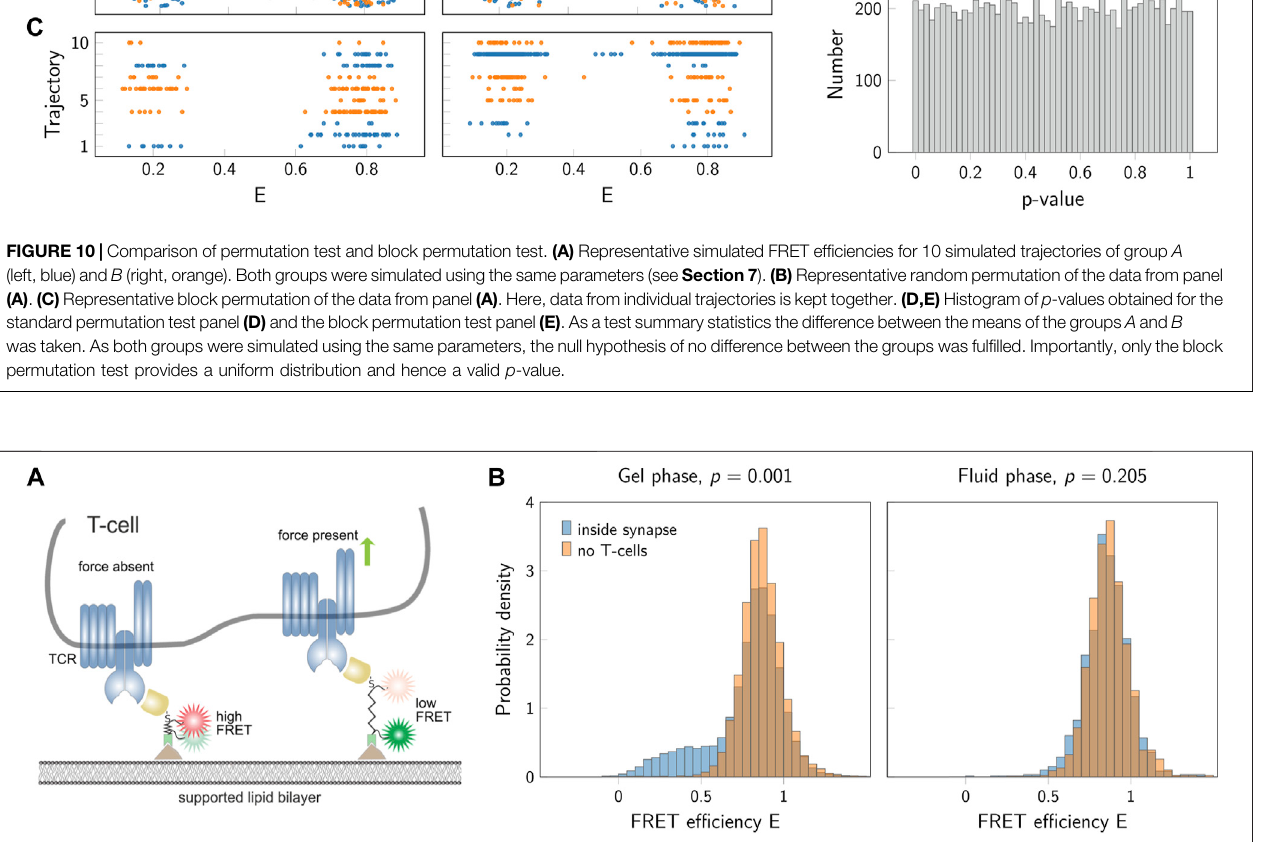
FIGURE11| FRET datafrom T-cellexperiments. (A) SketchofaT-celland the force sensor. Ifnoforceisapplied,thesensorshows ahigh FRETsignal(left). In the presenceofforces,alowFRETsignalisdetected(right). (B) FRETef fi cienciesforagel-phasebilayer(left)anda fl uid-phasebilayer(right).Thetwohistogramsshowdata inside the T-cell synapse (blue) and in the absence of T-cells (orange). The p -values indicated in the fi gure are the results of the block permutation test. The standard permutation test would yield a p -value of 0.001 and 0.004 for the gel- and fl uid-phase bilayer, respectively. Figure adapted from (Göhring et al., 2021), CC BY